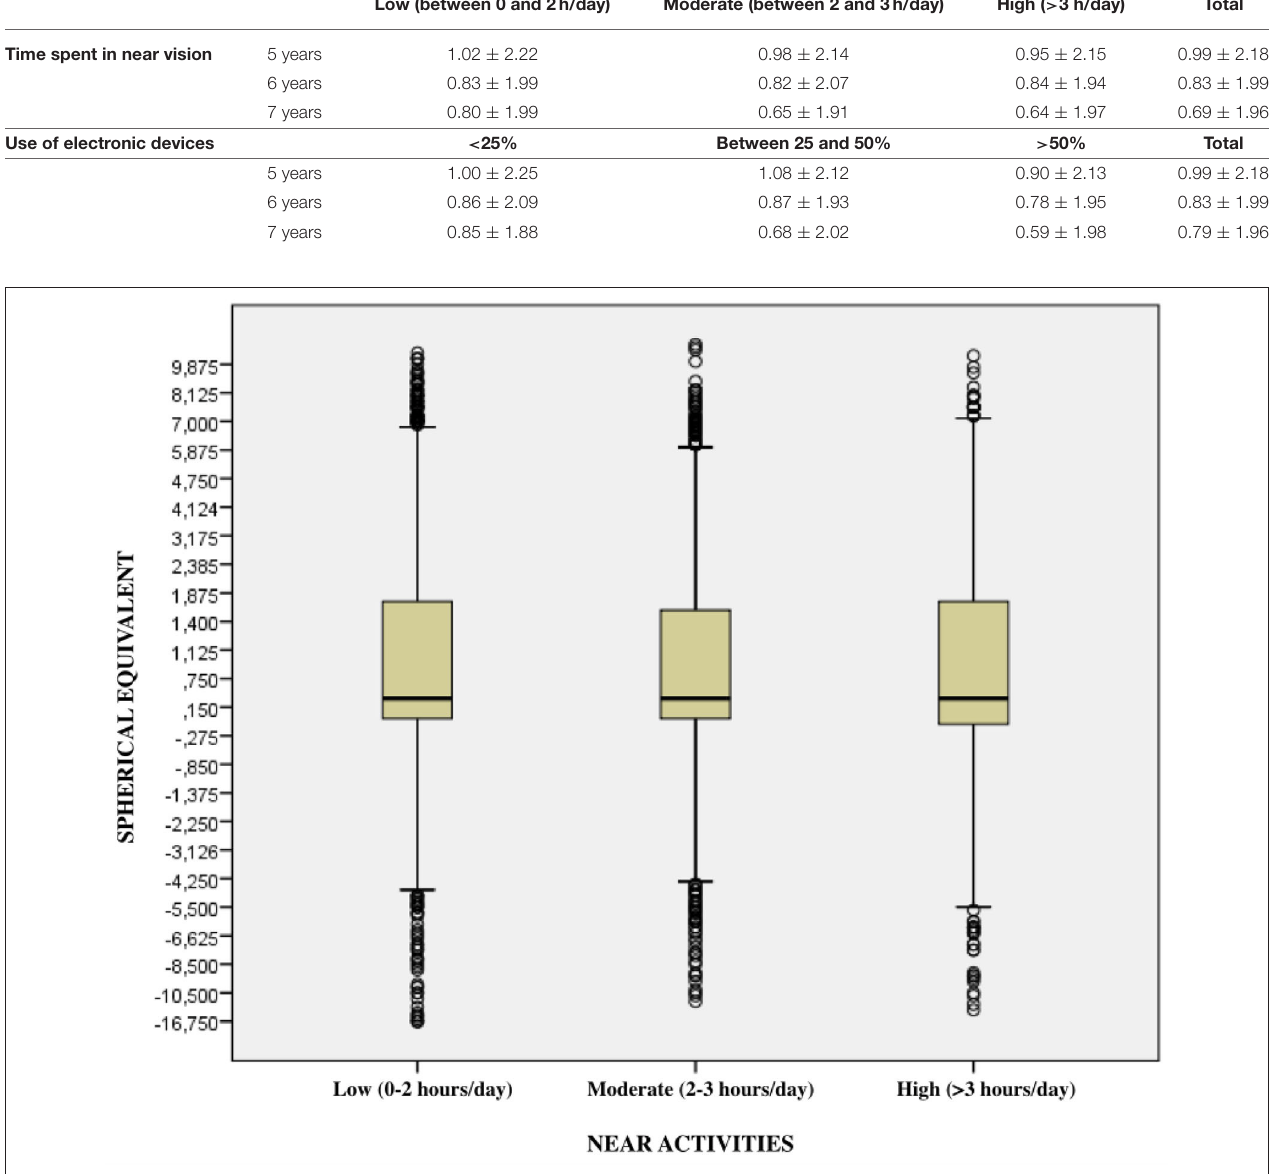
TABLE 4 | Spherical equivalent according to the time spent in near-vision activities and the use of electronic devices. Low (between 0 and 2h/day) Moderate (between 2 and 3h/day) High ( > 3 h/day)